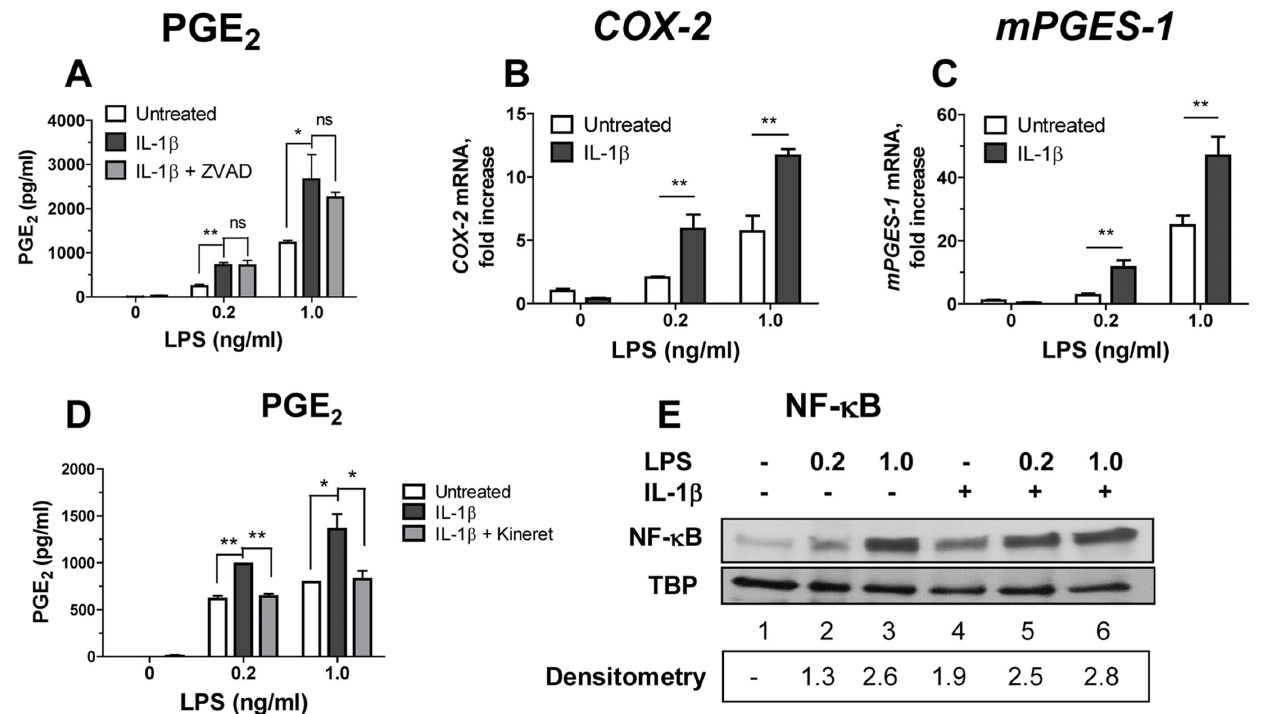
Figure 5. LPS priming is required for rIL-1 b -induced COX-2 and mPGES-1 mRNA up-regulation and PGE 2 production in monocytes. (A–D) Monocytes were left untreated or were primed with LPS for 1 h (open bars) or were primed with LPS followed by addition of rIL-1 b at 100 ng/ ml for 18 h (solid bars). In some cultures, LPS-primed monocytes were cultured with rIL-1 b in presence of ZVAD (10 m g/ml, panel A, grey bars) or Kineret (100 m g/ml, panel D, grey bars). Cell culture supernatants and cells were collected and were assayed for PGE 2 (A and D), or for COX-2 and mPGES-1 mRNA (B and C), respectively. The relative values of COX-2 and mPGES-1 mRNA expression were normalized using qPCR reactions with b - actin primers performed in the same samples. The data is shown as mean PGE 2 6 STDEV for triplicate wells in the PGE 2 assay and mean mRNA fold increases over untreated cells 6 STDEV calculated for triplicate wells in A and D and in B and C, respectively, **p # 0.001; *p # 0.05; ns, not significant (p $ 0.05). This experiment was performed with monocytes from three separate donors with similar results. The data is shown for one representative experiment. (E) Monocytes were left untreated (lane 1) or were treated with LPS at 0.2 or at 1.0 ng/ml alone (lanes 2 and 3) or with IL-1 b at 100 ng/ml alone (lane 4) or with LPS at 0.2 and at 1.0 ng/ml and IL-1 b together (lane 5 and 6). At 15 min post-treatment, nuclear extracts were obtained from collected cells and resolved in SDS-PAGE. NF- k B and TBP (control) were detected by Western Blotting. Densitometry values in lower panel represent fold increase in the intensity of NF- k B band in treated over untreated monocytes in this experiment (shown in lane 1). This experiment was performed twice with the same results; data are from one representative donor.